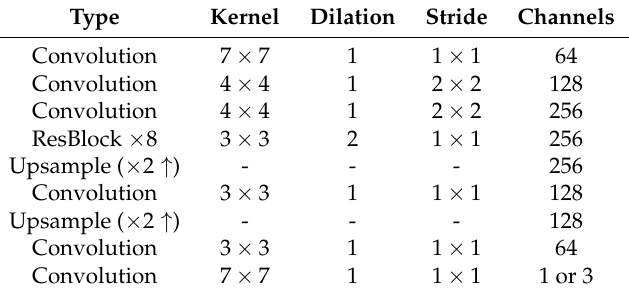
Table 1. Detailed architecture of the generators. After each convolutional layer, except the last one, there is a ReLU activation function. For G 1 , the output layer channel is 1, and for G 2 and G 3 , the output layer channel is 3. Type Kernel